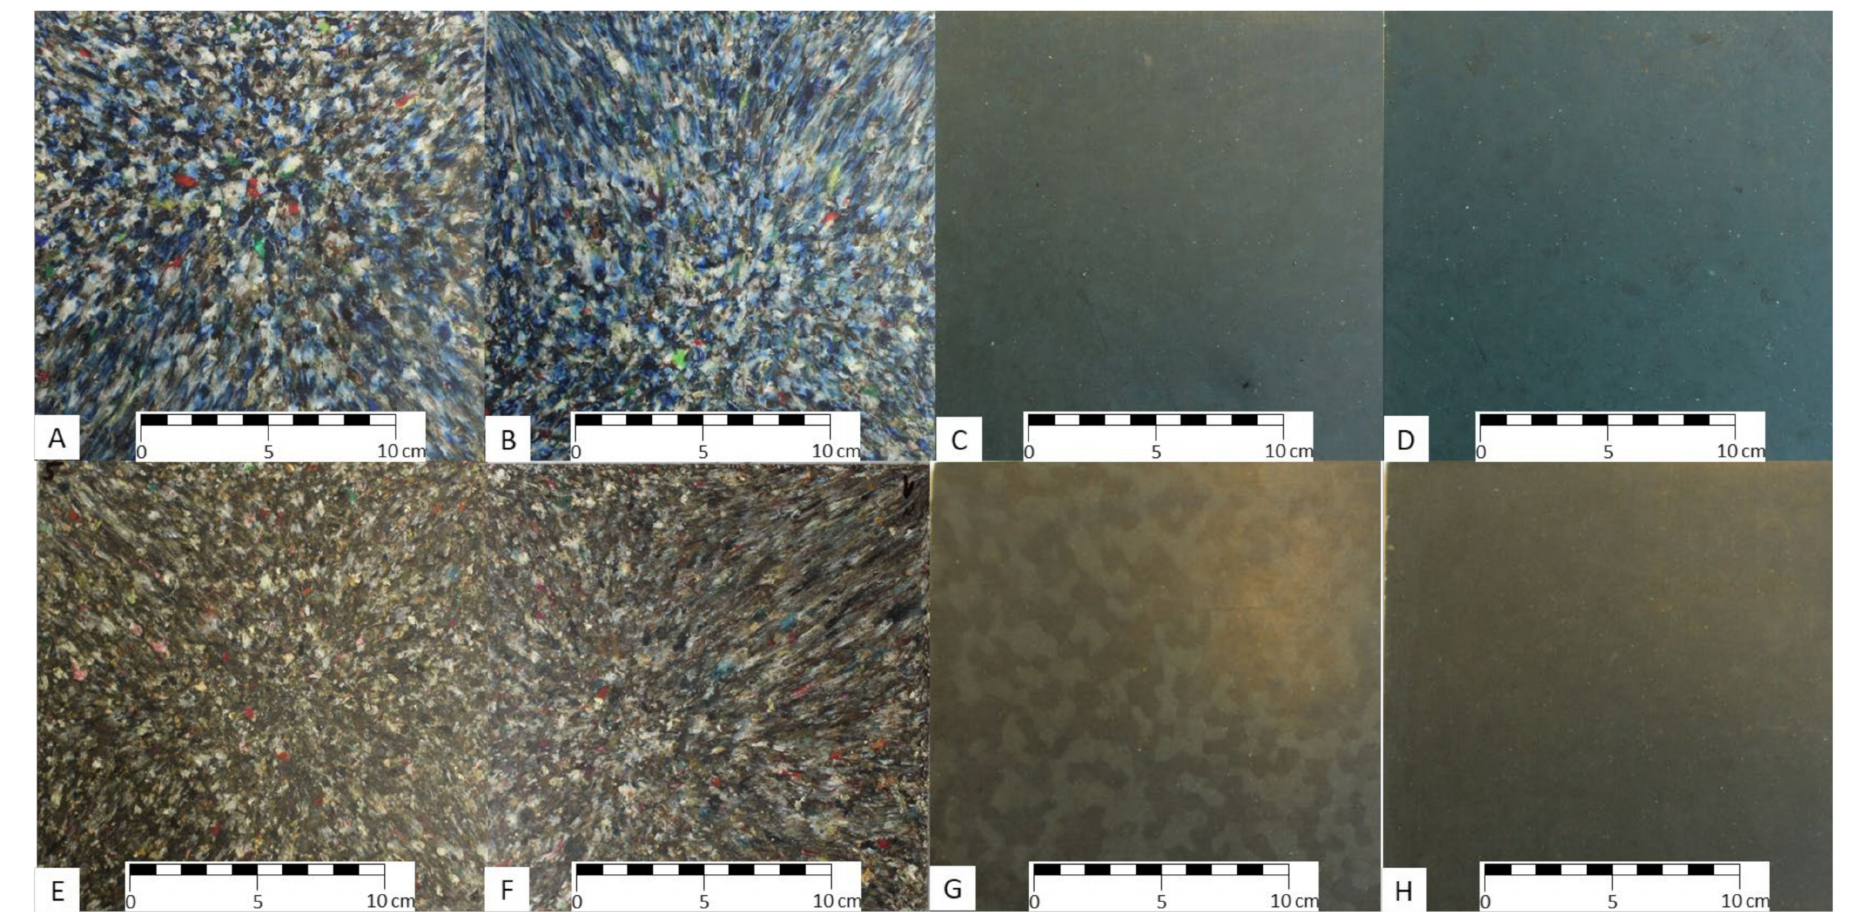
Figure A8. Exemplary photos of vacuum compression moulded plates: P_PS— A ; P_W,PS— B ; P_C,PS— C ; P_W,C,PS— D; PO_A— E ; PO_A,W— F ; PO_A, C – G ; and PO_A,W, C – H